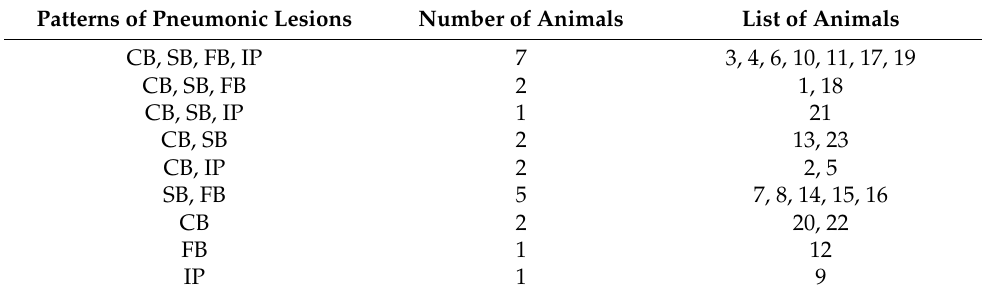
Table 3. Combination of pulmonary